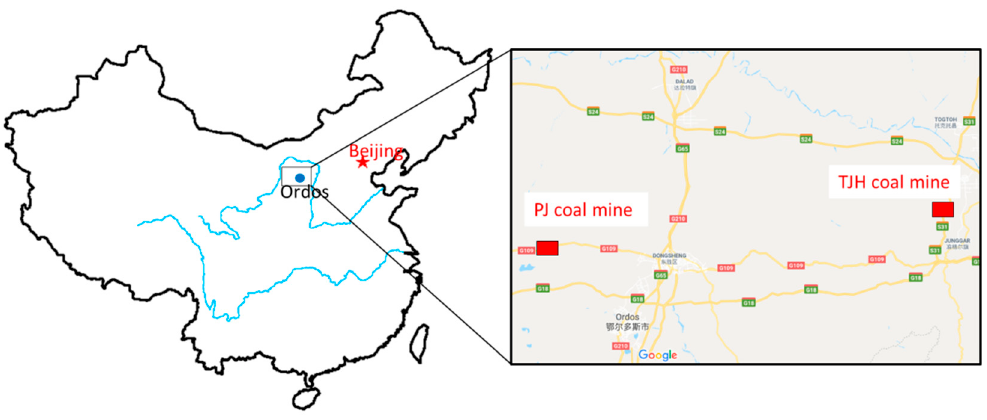
Figure 4. Locations of PJ and TJH coal mines.